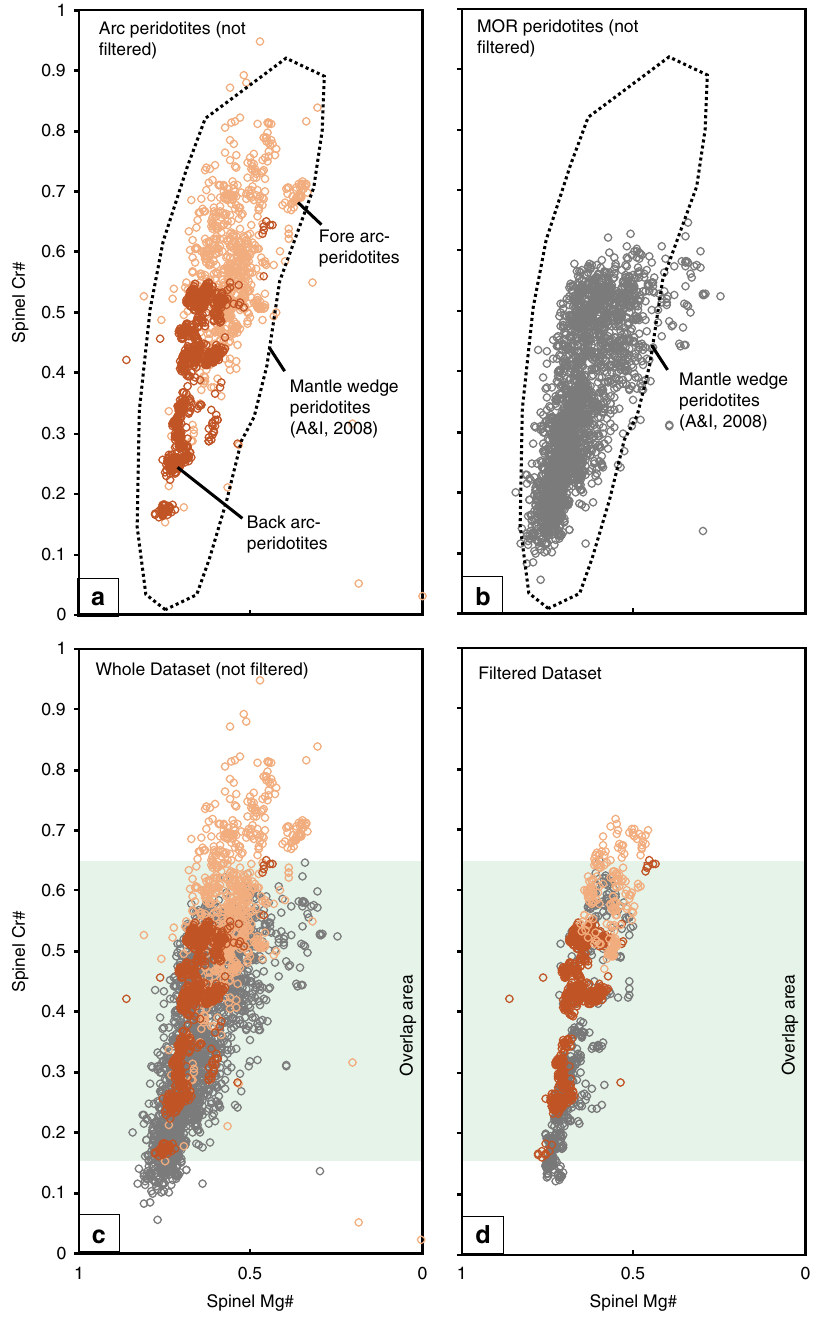
Fig. 6 Spinel Cr# and Mg# for the fore arc peridotites. a Cr-spinel database from arc-peridotites including fore arc settings (composed of mantle wedge xenoliths (e.g., the Kamchatka arc) 18,19 and dredged samples form present-day oceanic arcs (e.g., the Izu-Bonin-Mariana arc) 40,42 ) and back arc- peridotites (i.e., Mariana Trough) 43,44 . b Cr-spinel database from abyssal/ Mid-ocean ridge (MOR) peridotites. See Supplementary Data 3 for the arc and MOR-Cr-spinel datasets. All the arc and MOR-peridotites dataset plot within the Cr-spinel form mantle wedge peridotites 28 . c All arc peridotite Cr-spinel datasets (without fi ltering) plotted against MOR-peridotite one, showing their overlapping fi elds. d Filtered dataset for both arc- and MOR-peridotite are still completely overlapping. For fi lter details, see the methods. The shaded area in ( c , d ) marks the overlapping range of Cr# (0.15 – 0.65) between the arc- peridotite and MOR-peridotite fi